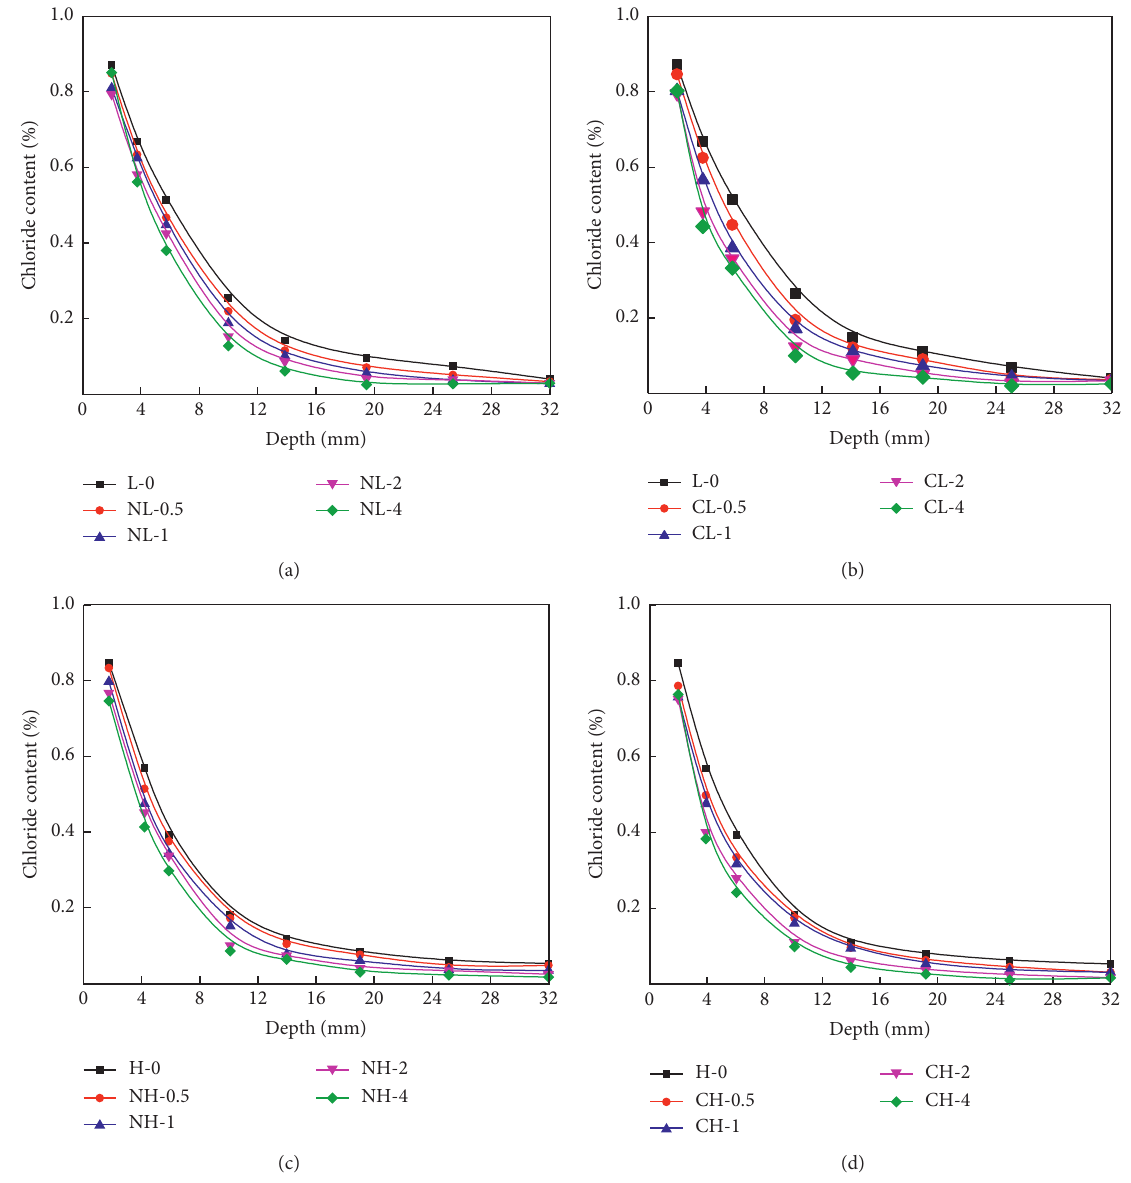
Figure 2: Chloride ion content of concrete. (a) C30 with N-LDH. (b) C30 with C-LDH. (c) C50 with N-LDH. (d) C50 with